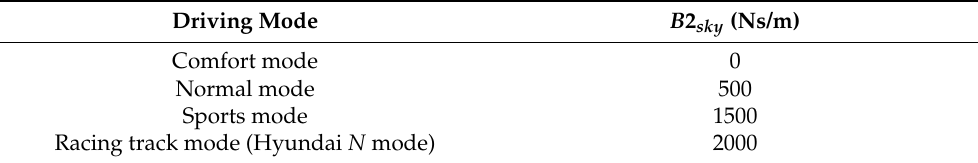
Table 4. Drive mode differentiation of the development